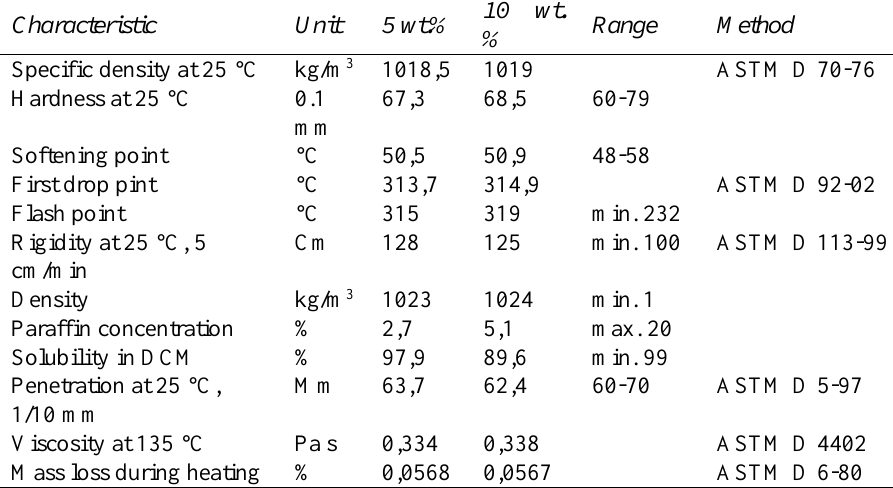
Table 3. Physicochemical and mechanical properties of bituminous material with 5 and 10 wt. % of Solidified material 2 (Experiment